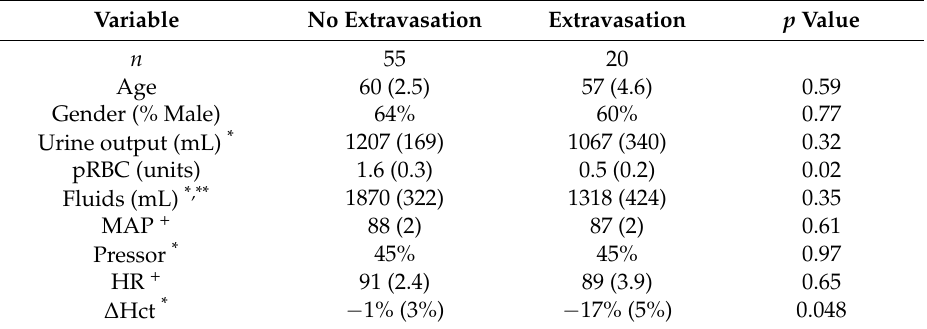
Table 1. Univariate analysis comparing studies with and without active extravasation.